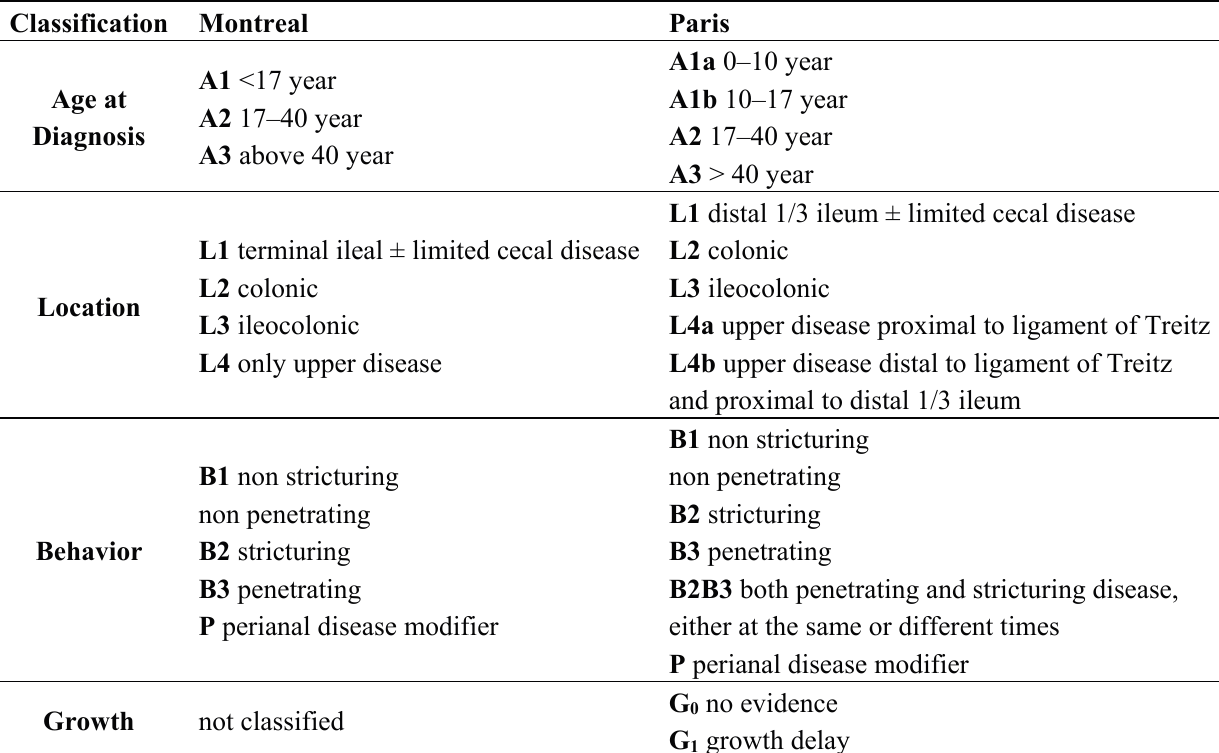
Table 1. Pediatric modification of the Montreal classification for inflammatory bowel disease: the Paris